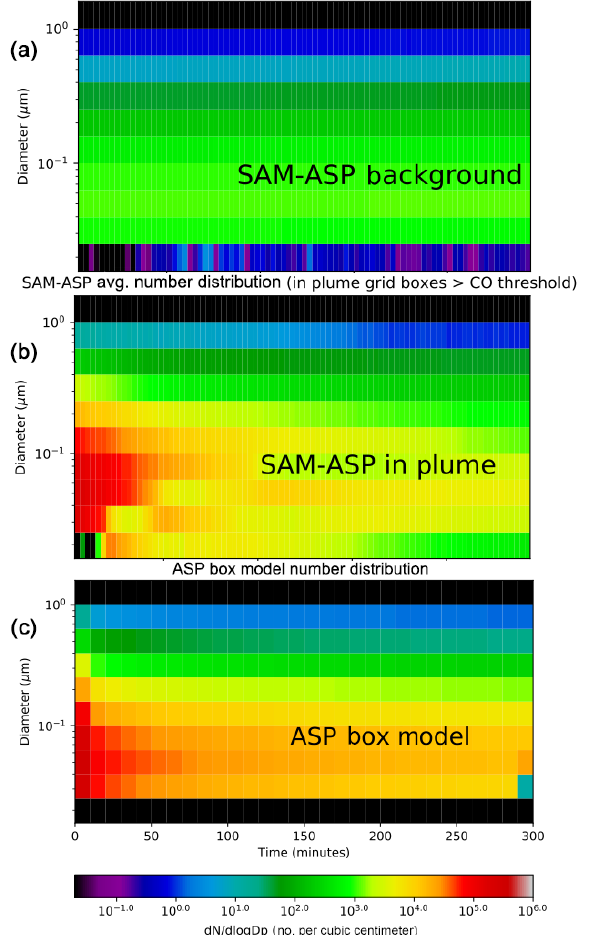
Figure 6. SAM-ASP (a, b) and ASP box model (c) simulated particle size distribution (d N/ dlog D p cm − 3 ) evolution within the Williams